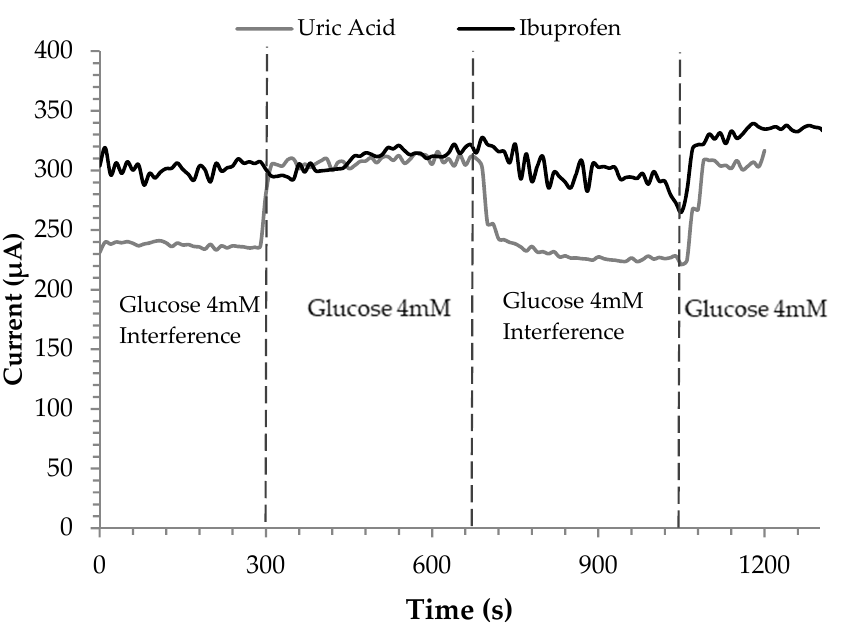
Figure 11. Pulsed Amperometric response of the copper oxide electrode in the presence of common interfering substances and 4 mM of glucose at +0.55 V (vs. Ag/AgCl) in 0.1M NaOH (pH 13). 0.41 mM uric acid and 0.05 mM ibuprofen.